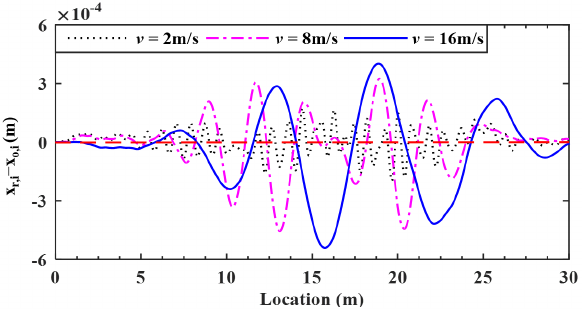
Figure 12. Deviations of surface profiles identified for different vehicle speeds.